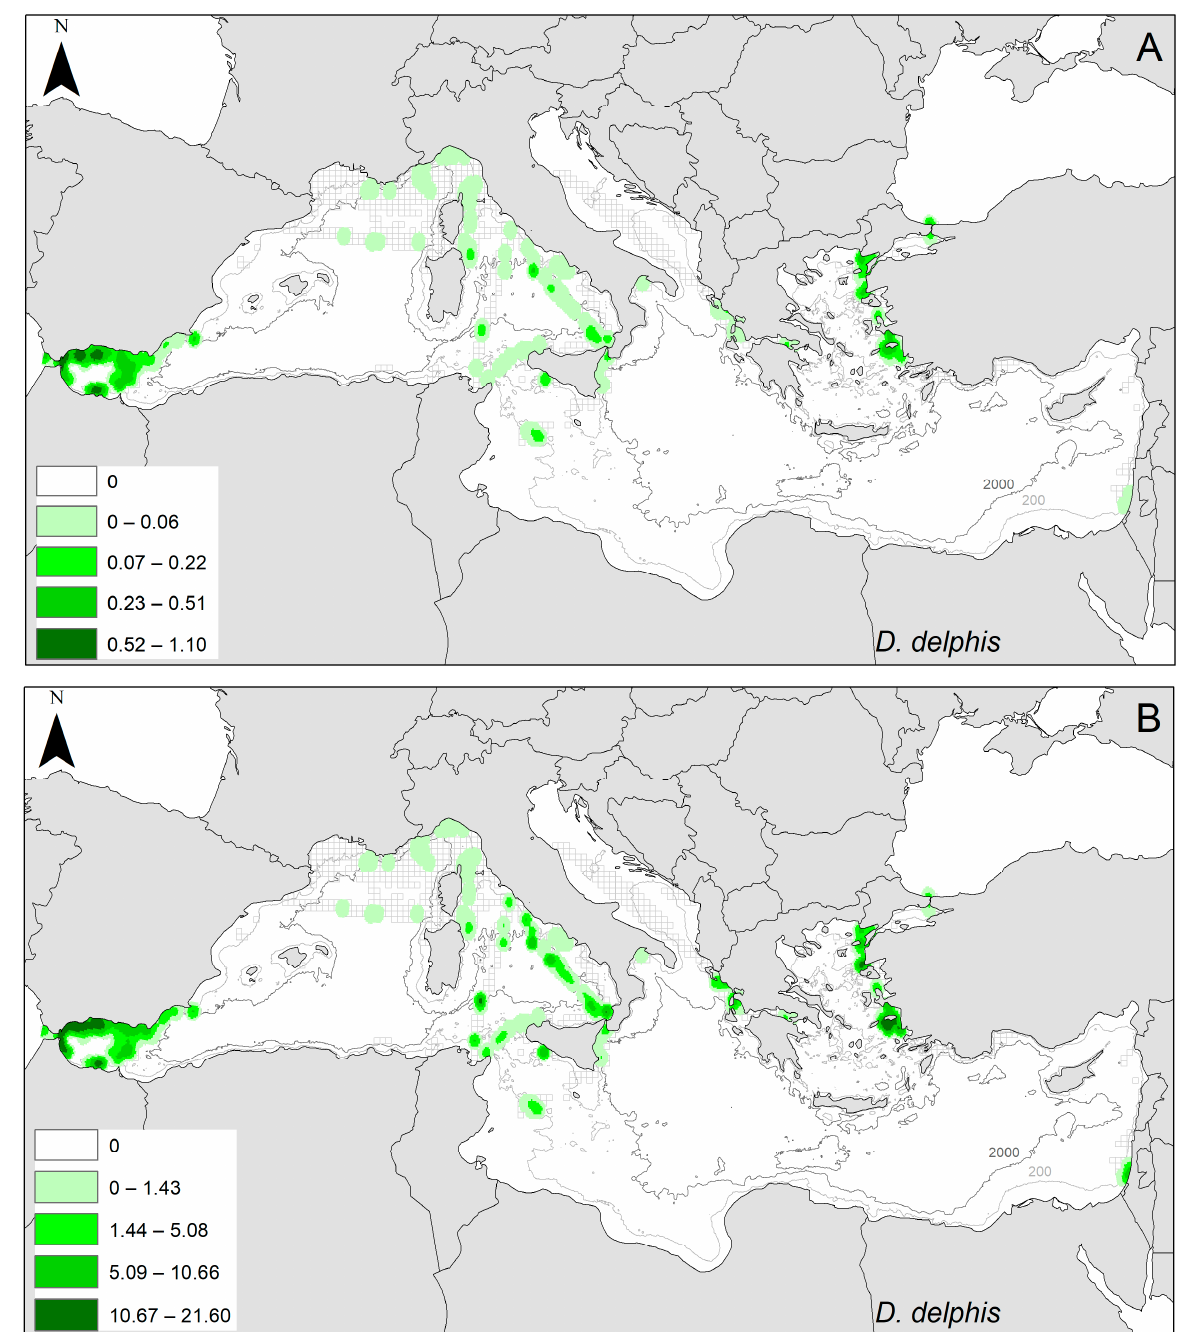
Figure 8. The encounter rate map ( A ) and the prevalence map ( B ) of the common dolphin ( Delphinus delphis ), processed through Kernel density analysis. The common dolphin was sighted in most of the areas sampled (except for the Adriatic Sea), with a very diverse and ubiquitous distribution. Its ER is maximum in the Alboran Sea, where this species seems to find its favoured habitat in the waters of the continental shelf and slope. In the Ligurian and Tyrrhenian Sea, its ER is much lower, and this species seems to prefer the open waters outside the continental shelf (>200 m). In the Aegean Sea, the ER increases and the common dolphin seems to find its privileged habitat at the upper edge of the continental slope, close to the platform. The prevalence map ( B ) shows an inverse pattern to that of the striped dolphin (Figure 6B), with prevalence levels increasing from north to south and from west to east (Kernel density parameters: cell size x, y = 5 × 5 km; radius ≈ 30 km; criterion for division into classes: natural breaks).